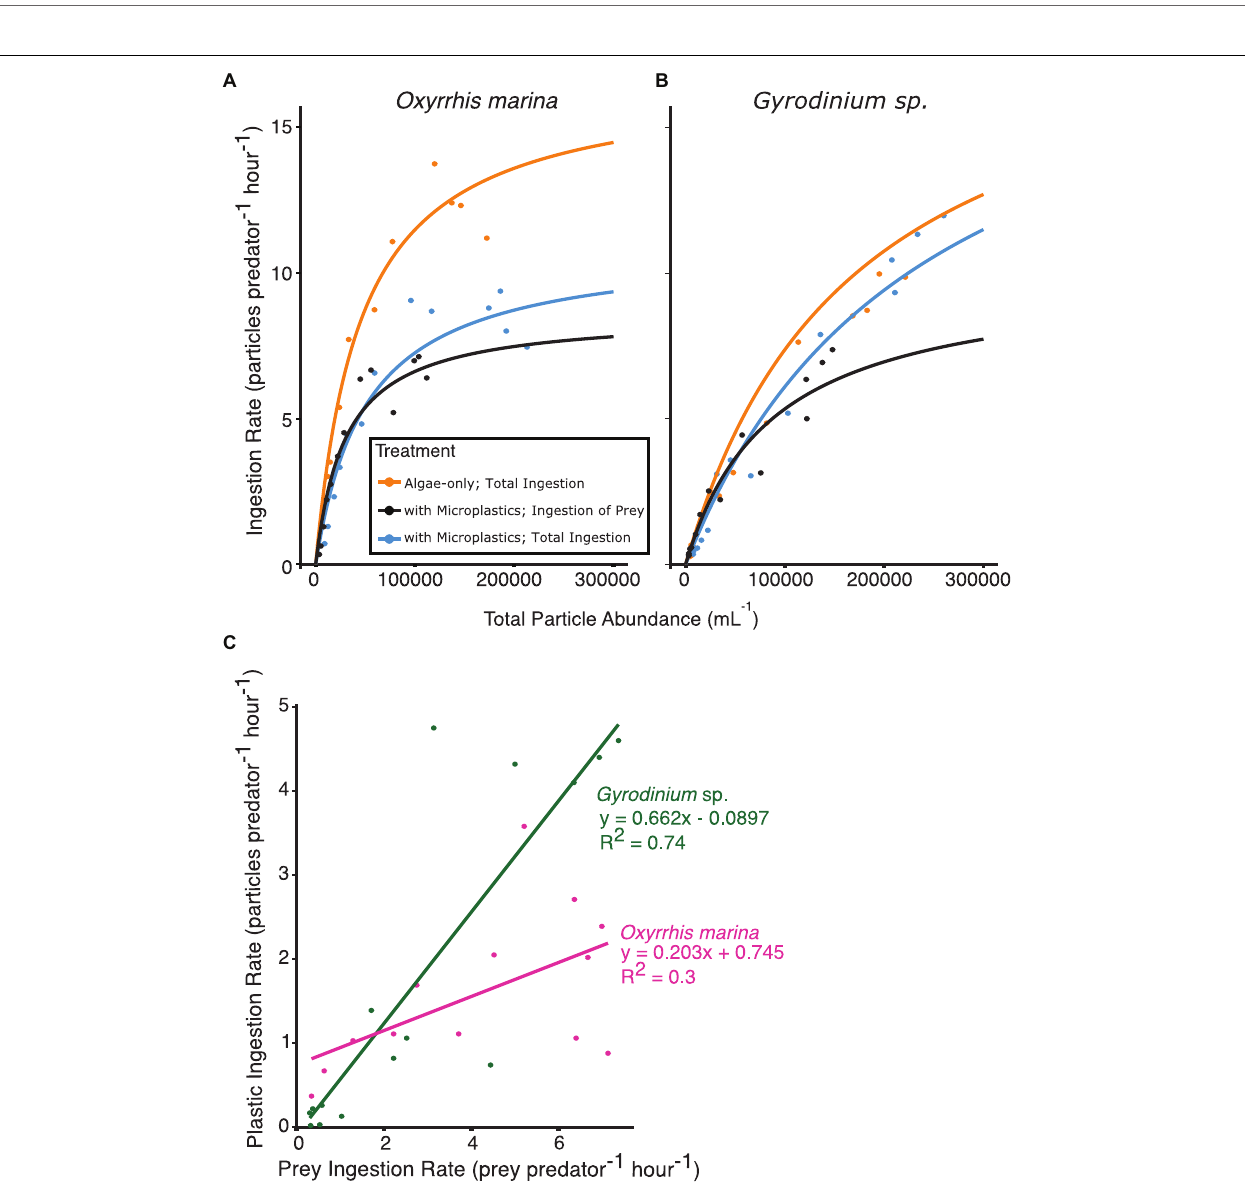
FIGURE 5 | Functional response curves from short-term, 3 h feeding experiments, fit to the ingestion rate and total particle abundances for (A) O. marina and (B) Gyrodinium sp. fed algal prey, or a mixture of algal prey and microplastics. Ingestion rates of algal prey (orange and black) as well as total ingestion of all particle types present (orange and blue) are shown for comparison. The relationship between the rate of plastic ingestion and rate of prey ingestion (C) when both prey types are at equal concentrations reveals the selectivity factor of each species between microplastic particles and algal prey. O. marina ( C , pink) showed higher selectivity for prey than Gyrodinium sp. ( C ,